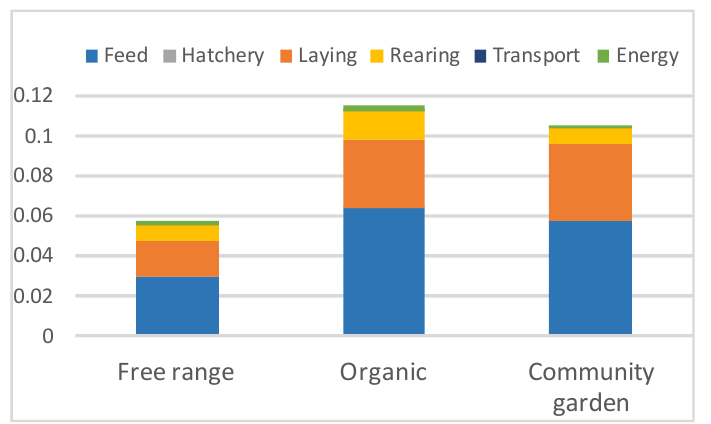
Figure 4. Normalized and weighted results for eggs produced in a community garden compared with free-range and organic eggs, using Environmental Footprint 3.0 for one kilogram of eggs.